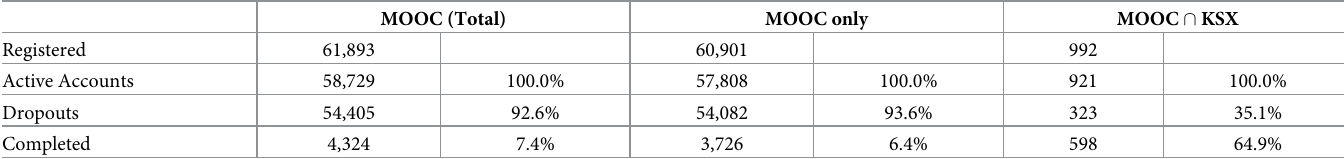
Table 1. MOOC and KSX participation.